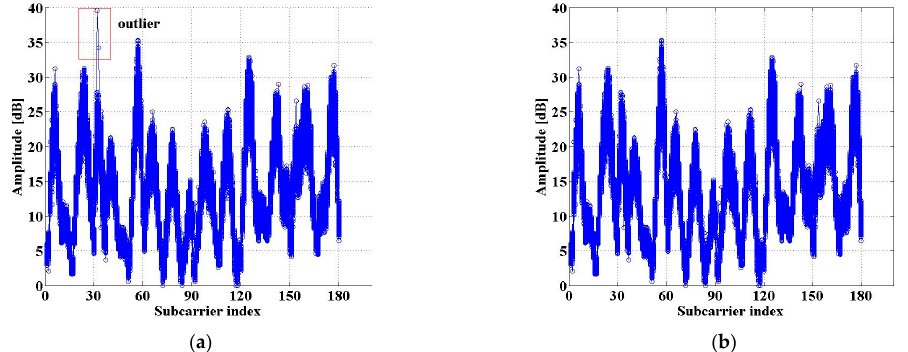
Figure 5. Effectiveness of noise reduction preprocessing: ( a ) The amplitude data of CSI-MIMO before processing; ( b ) The amplitude data of CSI-MIMO after processing.